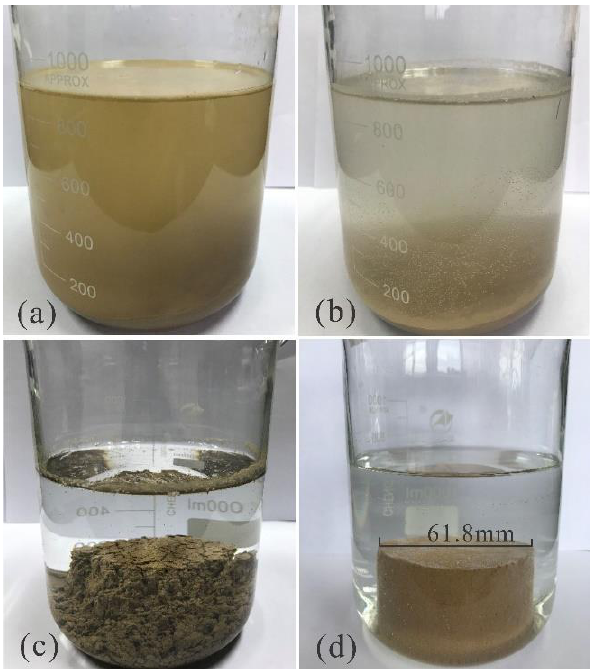
Figure 2. Comparison of the disintegration of the reinforced soil with different stabilizer concentra- tions: ( a ) 0%; ( b ) 0.2%; ( c ) 0.4%; ( d ) 0.6%.